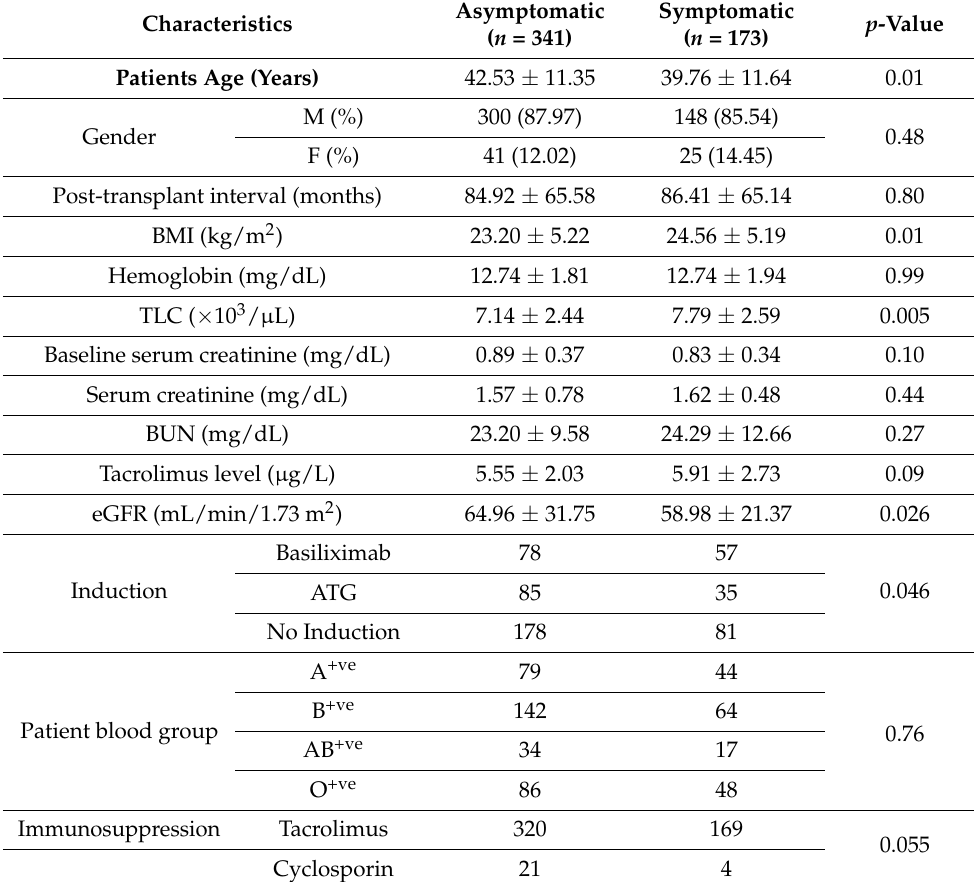
Table 1. Demographic and clinical profile of RTRs with asymptomatic and symptomatic infection.